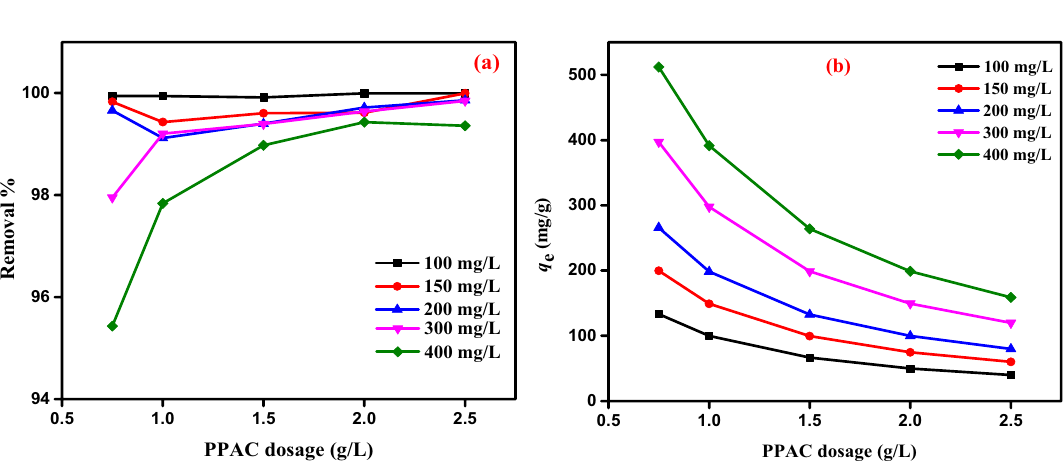
Figure 9. Impact of PPAC various doses (0.75–2.5 g/L) of various C 0 of AY11 dye (100–400 mg/L) ( a ) on percentage of removal; ( b ) on q e (mg/g), and Temp. (25